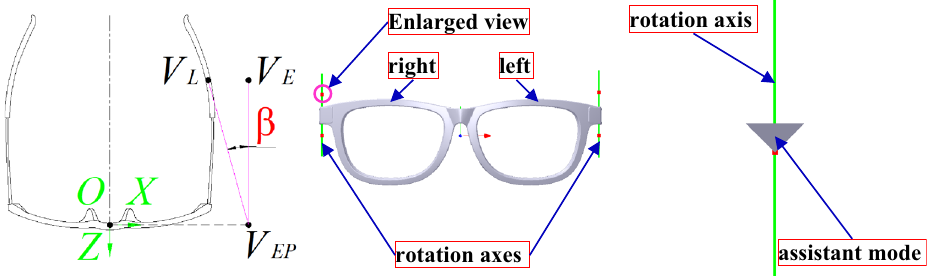
Figure 21. The transformation definition of the pile head. From left to right: the definition of angle between the leg and the face, the rotation axes of the pile head marked with green lines, the rotation axis of the pile head with a partial enlarged